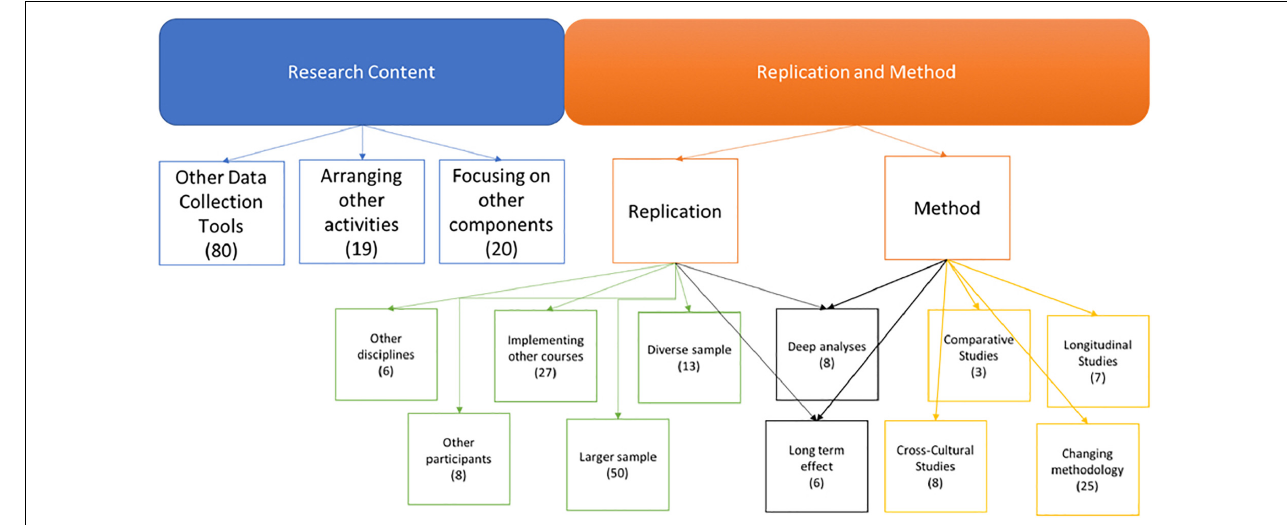
FIGURE 5 | Code and